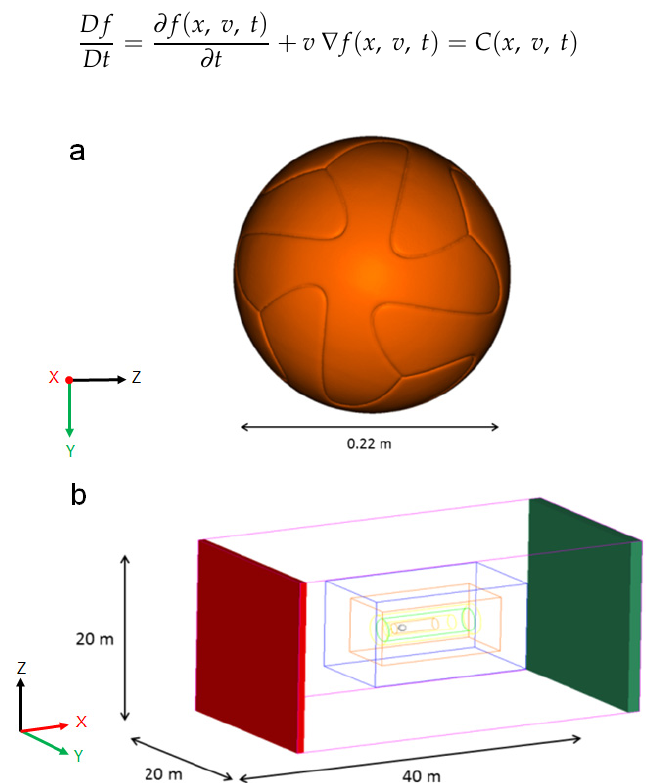
Figure 1. ( a ) Three-dimensional soccer ball model obtained by laser scanning and ( b ) the Cartesian grid used to generate a spatial grid (W 20 m × H 20 m × L 40 m) for computational fluid dynamics (CFD) analysis. The flow is from the left to the right.